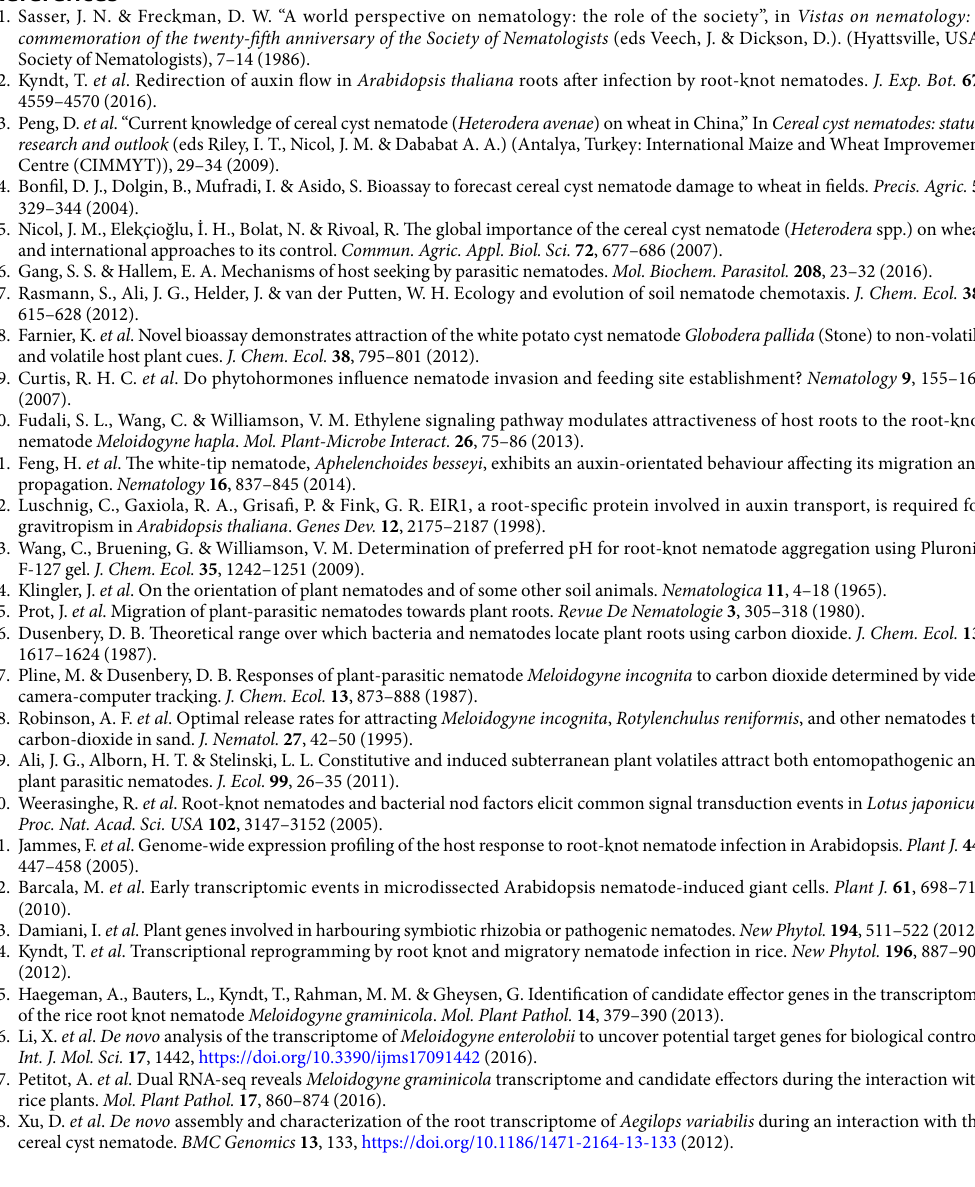
H. avenae effector prediction. The sequences of 351 known parasitism effectors of PPNs (Supplementary Table S4) were collected and aligned with the H. avenae DEGs. Putative effector genes were obtained using an E -value ≤ 1e-5. Structural domain prediction of the genes was conducted by blasting the gene sequence at NCBI (http://blast.ncbi.nlm.nih.gov/Blast.cgi). Cell-death suppression assay in N. benthamiana . To detect plant defence suppression, two predicted effector genes from the H. avenae DEGs (i.e., c68622.graph_c0 and c72543.graph_c0 ) were constructed in a PVX vector pGR107 (with the CP promoter) containing a flag-tag fused at the N-terminal, following the instructions of the In-Fusion HD Cloning Kit (Clontech, Palo Alto, CA, USA), with the primer pairs c68622-107f-S1/AS1 and c72543-107f-S1/AS1 (Supplementary Table S9). Construct of pGR107::Bax was provided by Dr. B.Y. Xie of the Chinese Academy of Agricultural Sciences, China. The constructs were verified by sequencing prior to transfor- mation into Agrobacterium tumefaciens strain GV3101. Plants of N. benthamiana were grown in a greenhouse for 4 to 6 weeks at 25 ± 2 °C under a photoperiod of 16 h light/8 h dark. An assay of the suppression of BT-PCD was carried out as described by Chen et al . 79 , except that 10 mM 2-(N-Morpholino) ethanesulfonic acid, 4-morpholineethanesulfonic acid (MES, pH 5.6) and 200 μ M acetosyringone were added to 10 mM MgCl 2 as the infiltration buffer. This assay was repeated twice, using 5 plant replicates in which three leaves were inoculated per plant. Data